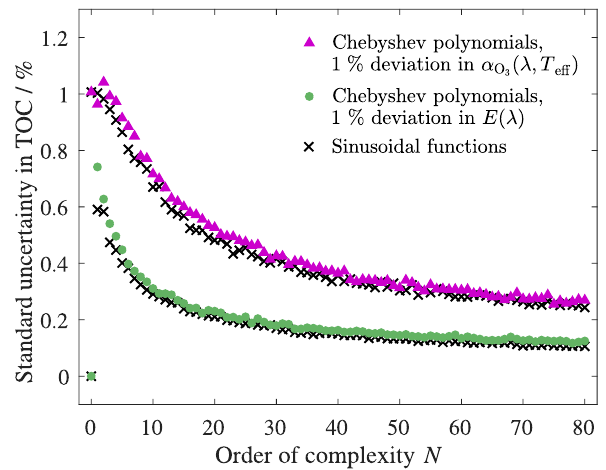
Figure B2. Standard uncertainties in TOC simulated using a local noon spectrum of QASUME with Chebyshev polynomials as base functions. The TOC uncertainties with the input standard deviation of 1% in the spectral irradiance values are shown as green circles and the TOC uncertainties with the input standard deviation of 1% in the ozone absorption cross section are shown as magenta trian- gles. Standard uncertainties simulated with sinusoidal base func- tions (black crosses) from Fig. 5a are plotted for